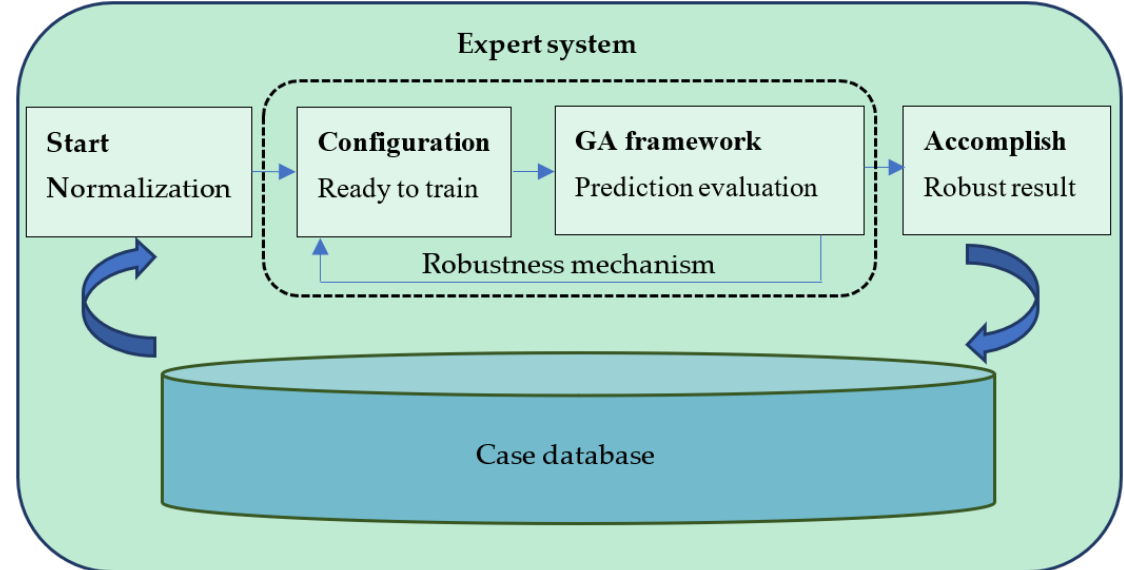
Figure 1. Architecture of the robust design-based expert system.